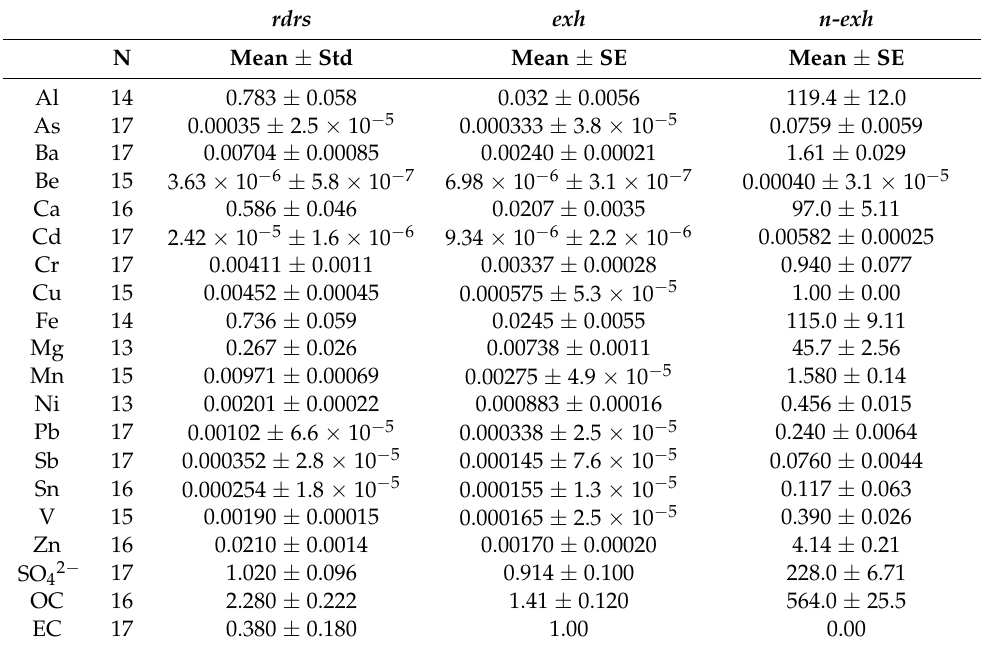
Table 2. Source profiles of the rdrs , exh , and n-exh vehicular sources for a mixed fleet (mass of X to mass of corresponding marker element